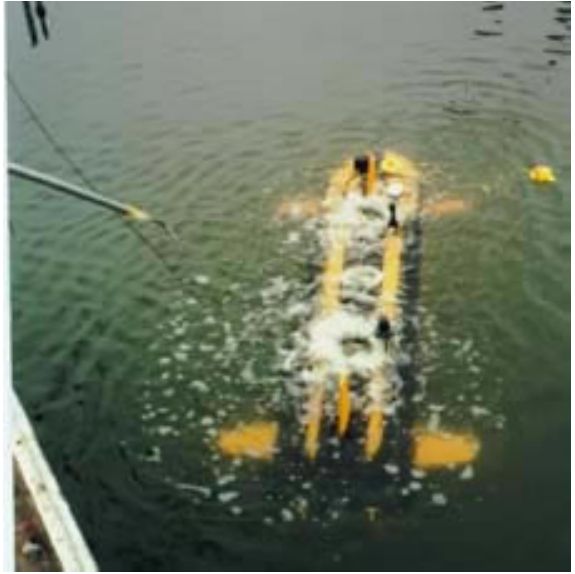
Figure 1. Phoenix unmanned underwater vehicle.